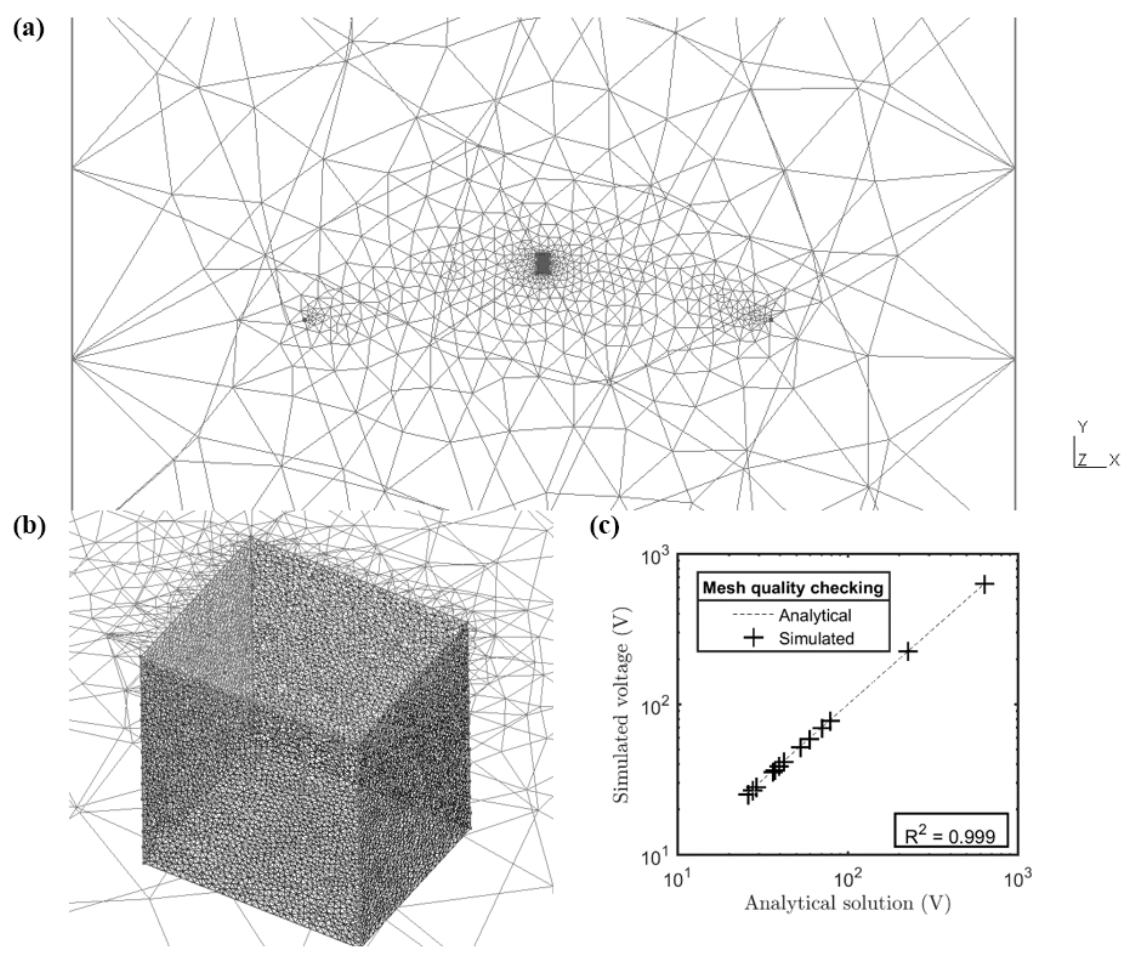
Figure A2. Plot of the finite element mesh used in this paper. (a) shows the position of remote electrodes in the mesh and position of the stem; (b) a zoomed-in image around the stem showing a mesh size approximately 5 times smaller than the electrode spacing; and (c) the plot showing the excellent correlation ( R 2 = 0 . 99) between numerical simulation results and the analytic solution for a homogeneous model with resistivity equal to 100 (cid:127) ·